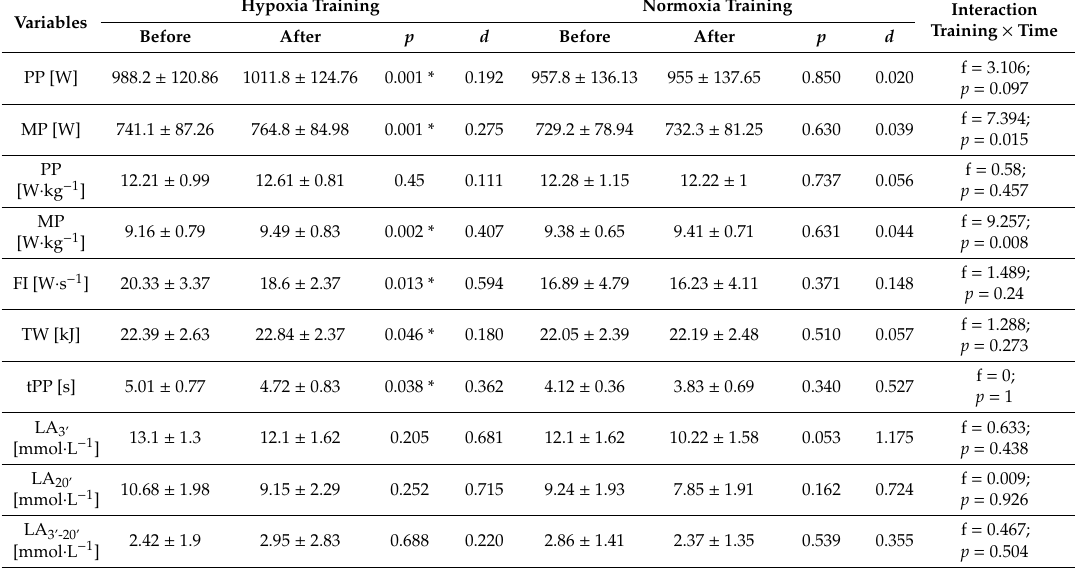
Table 4. Changes in indices of anaerobic capacity under the influence of training in conditions of hypoxia and normoxia.